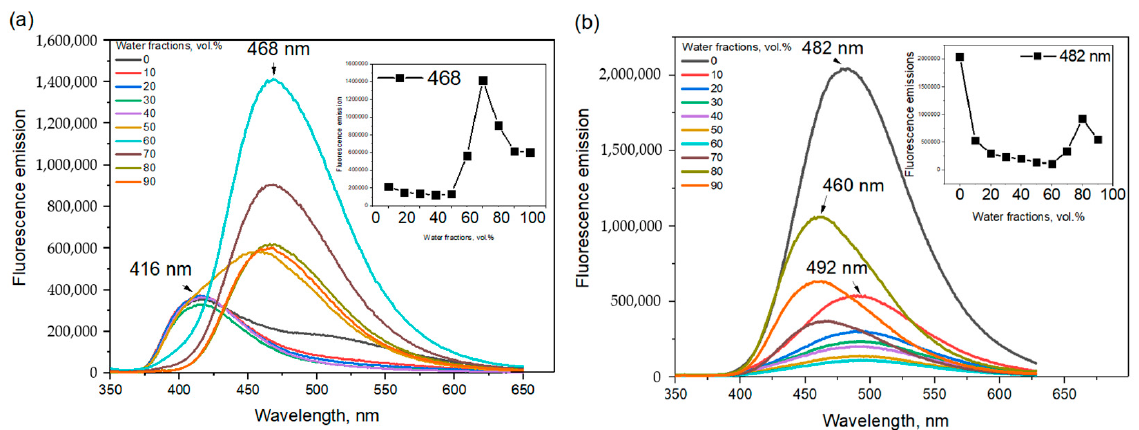
Figure 8. AIEE of 3l ( a ) and 3b ( b ) in acetonitrile-water mixtures (10 − 5 M concentration, room temperature, λ ex 342 nm). Insets: ( a ) a plot of fluorescence intensity of 3l at 468 nm at different f w values ( b ) a plot of fluorescence intensity of 3b at 482 nm at different f w values .